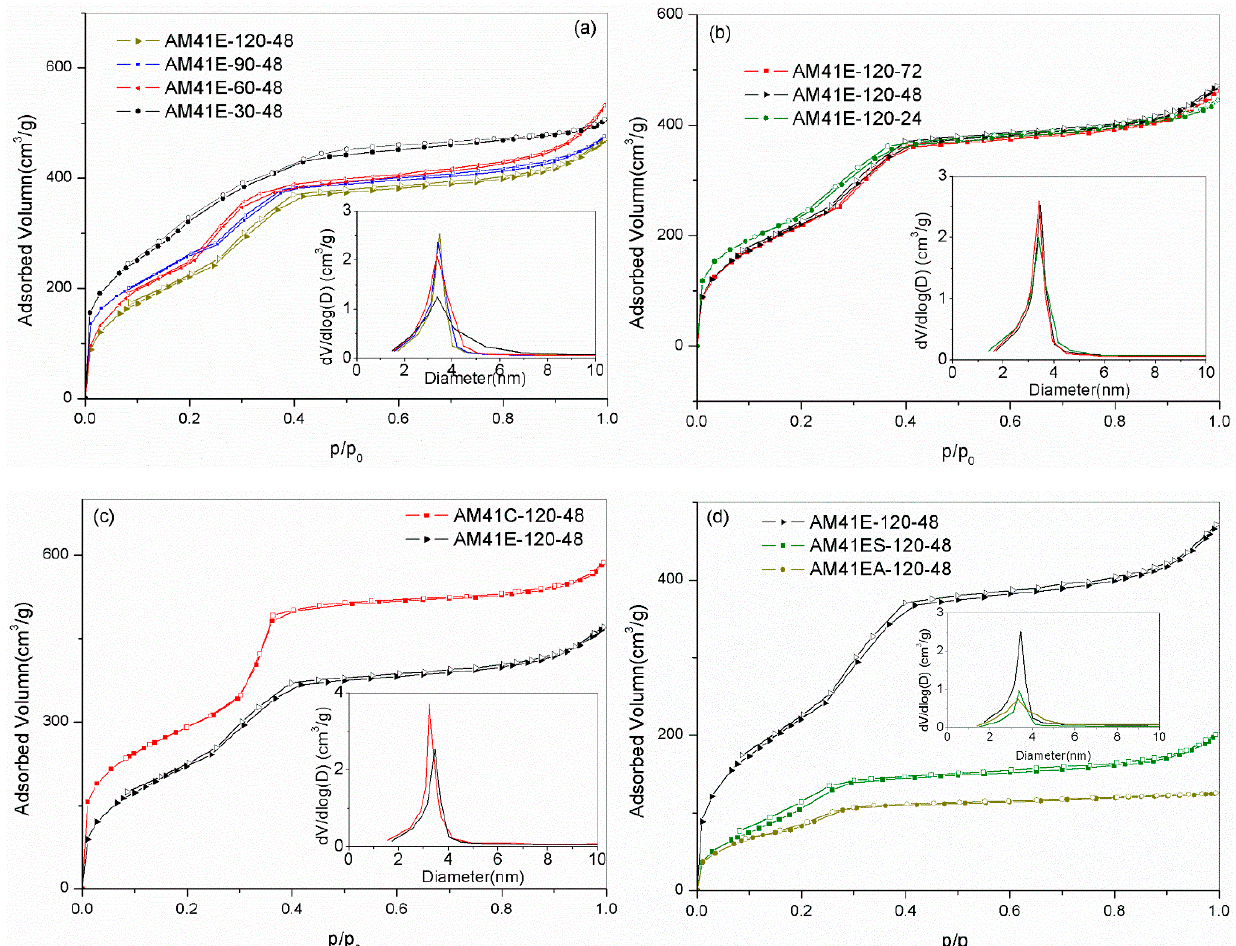
Figure 5 . N 2 adsorption–desorption isotherms for ( a ) AM41E-120-48, AM41E-90-48, AM41E-60-48, and AM41E-30-48 (+50), ( b ) AM41E-120-72, AM41E-120-48, and AM41E-120-24, ( c ) AM41E-120-48 and AM41C-120-48, and ( d ) AM41E-120-48, AM41ES-120-48, and AM41EA-120-48.